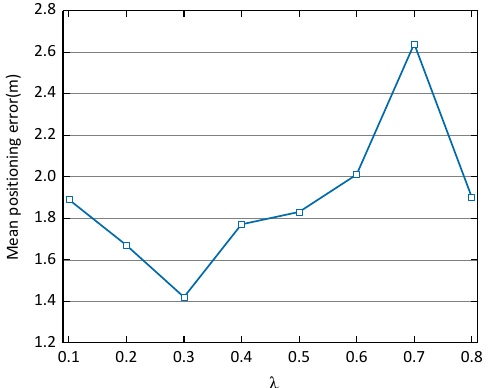
Figure 6. Effects of noise coefficient λ on positioning performance.